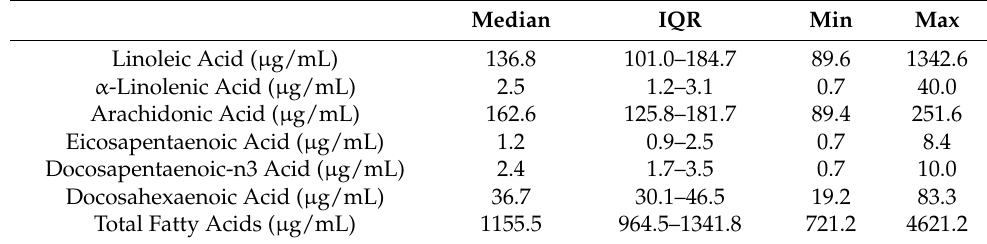
Table 3. Concentrations of PUFAs in Umbilical Cord